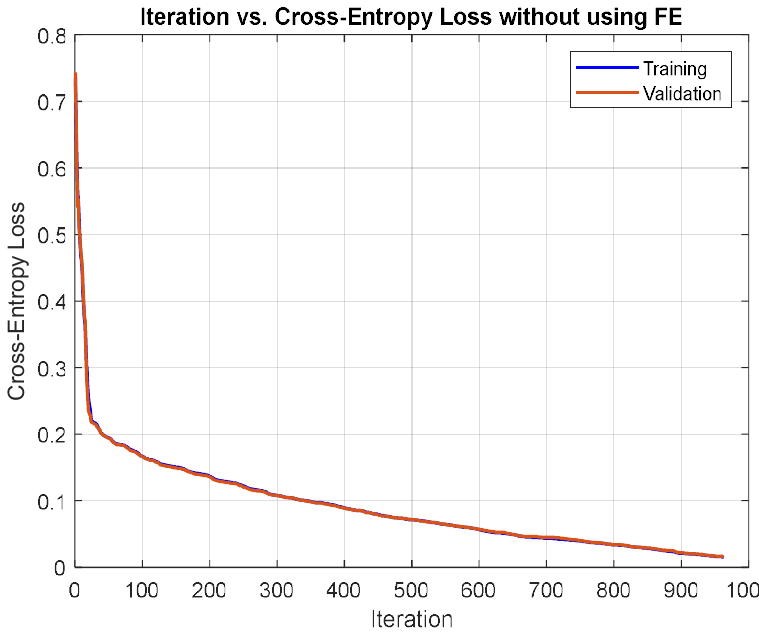
Figure 6. Iteration vs. cross-entropy loss for features extraction of noisy signals with length 6400 and three hidden layers with (30, 25, 20) nodes. Note that increased layers and nodes lead to an accuracy of 98 with fewer iterations of 158.